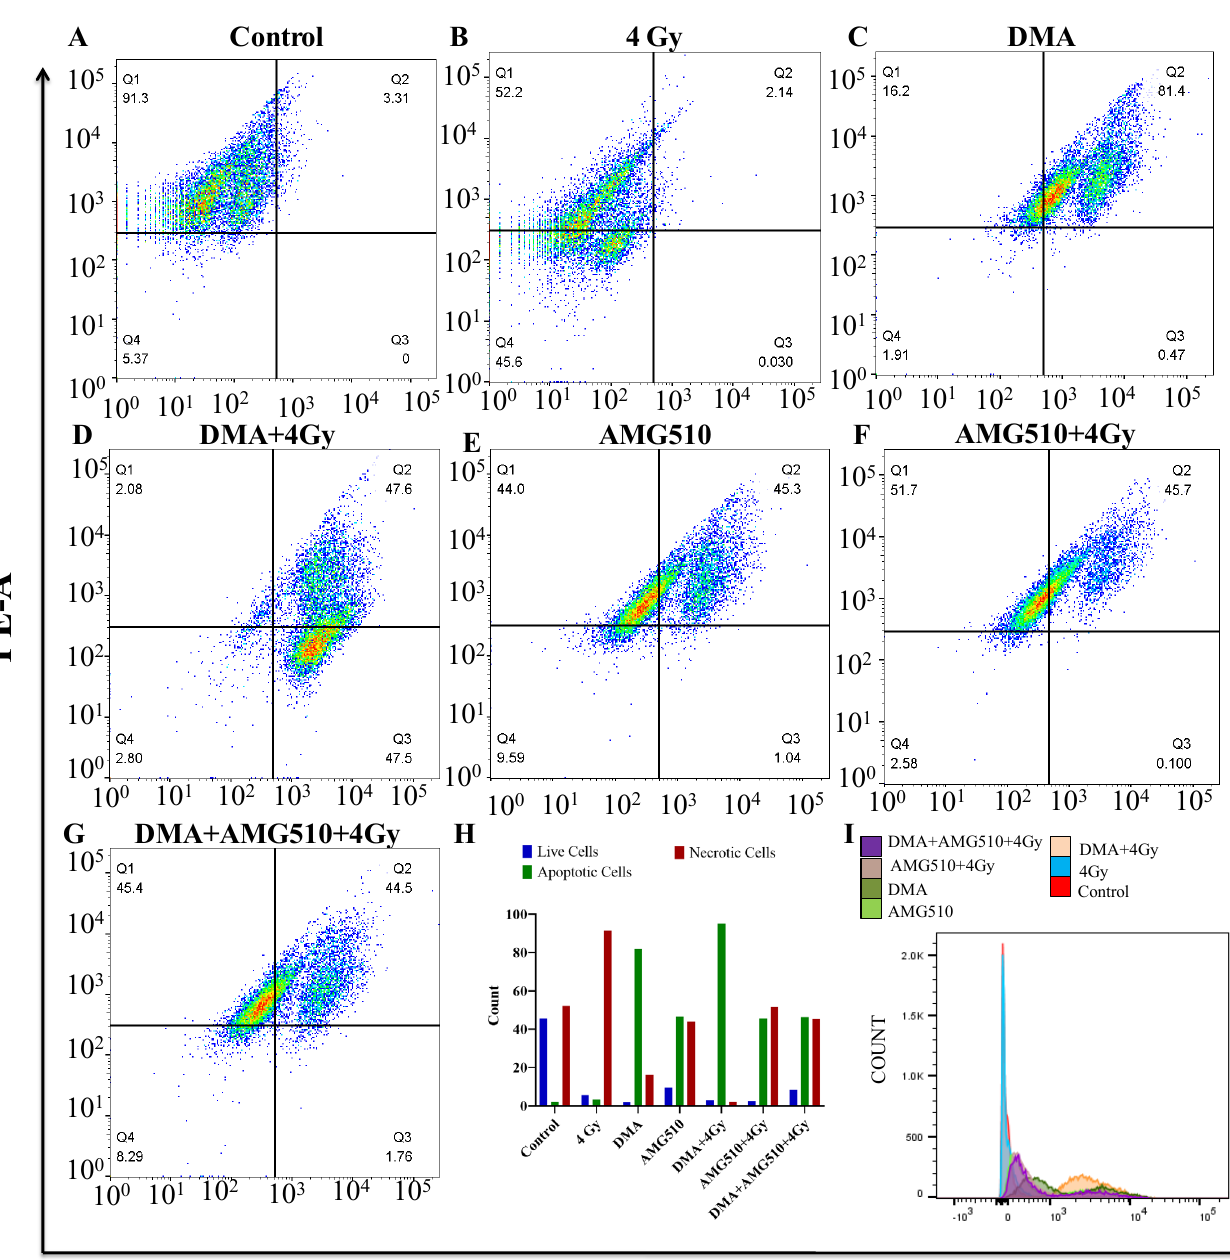
Figure 8. DMA induces apoptosis in nasopharyngeal HK-1 cells. Contour diagram of the annexin V-FITC/PI flow cytometry of nasopharyngeal HK-1 cells: ( A ) control, ( B ) radiation (4 Gy), ( C ) DMA (6.25 µM), ( D ) DMA + radiation (6.25 µM + 4 Gy), ( E ) AMG 510 (10 µM), ( F ) AMG 510 + radiation (10 µM + 4 Gy), and ( G ) DMA + AMG 510 + radiation (6.25 µM + 10 µM +4 Gy). The lower left quadrant (Q4) of the cytograms shows the viable cells, which excluded PI and were negative for annexin V-FITC binding. The upper right quadrant represents late apoptotic cells, positive for annexin V-FITC binding and showing PI uptake (Q2). The lower right quadrant (Q3) represents the apoptotic cells, annexin V-FITC positive and PI negative, demonstrating annexin V binding and cytoplasmic membrane integrity. ( H ) Quantitative percentages (count %) of live, apoptotic (early and late apoptotic cells), and necrotic cells. ( I ) Histogram of the population of cells (count %) undergoing apoptosis stained with annexin V.